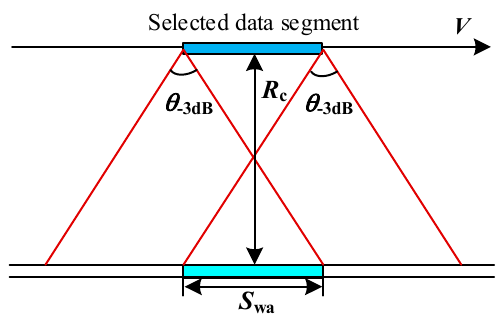
Figure 4. Track segment selection for the data stitching.